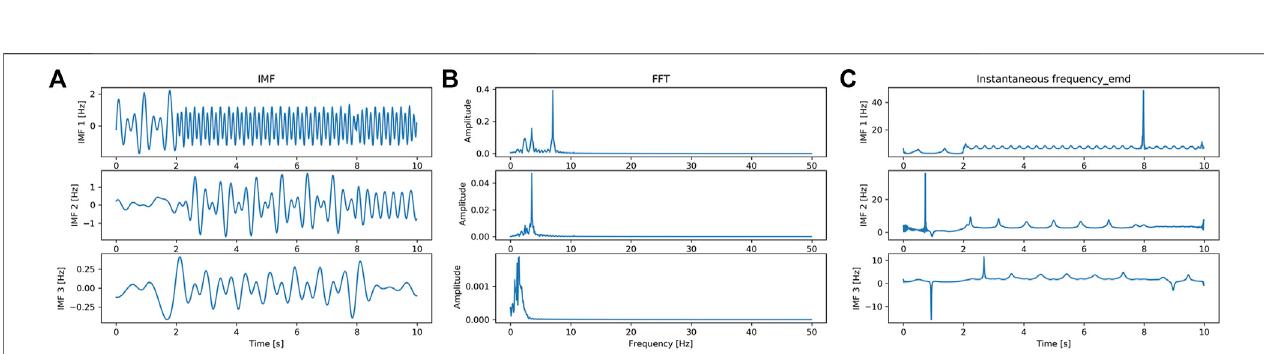
Frontiers in Physics |